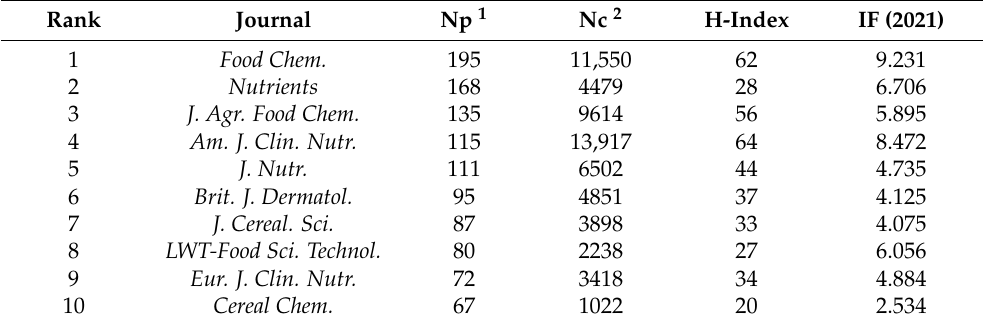
Table 1. The top 10 most active journals.